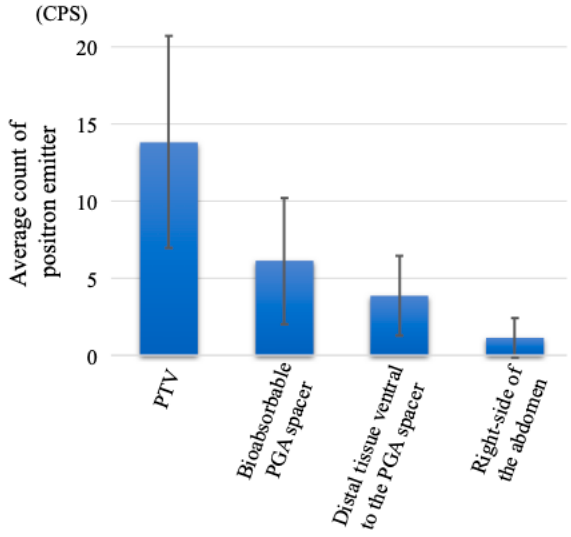
Figure 5. Counts per second of positron emitters in the planning target volume, the bioabsorbable PGA spacer, the distal tissue ventral to the PGA spacer, and the right side of the abdomen (out of the irradiation field). Data were presented as the mean ± standard deviation for all pixel value data in both the third and fifth fraction images for each contour. Data were compared for all combinations, and p -values were less than 0.05 for all tests.